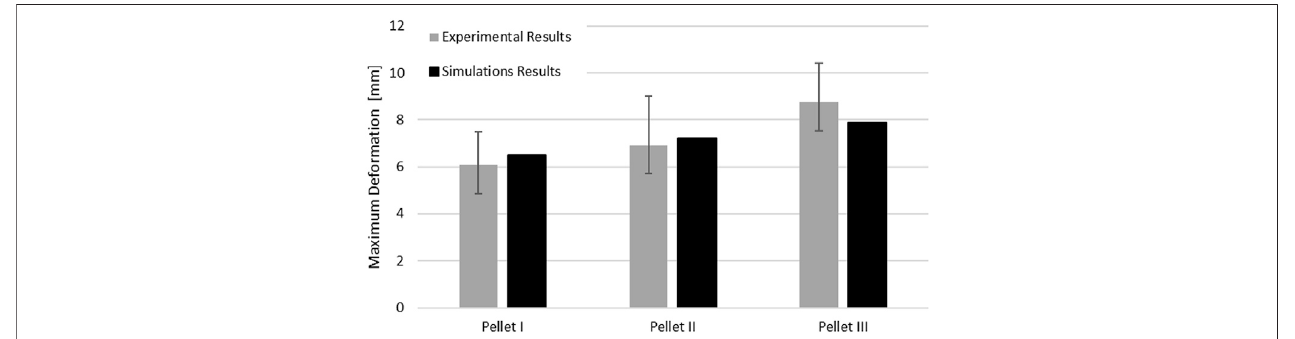
FIGURE 8 | Comparison of the maximum deformation of the SCP complex for three impacts with experimental data.